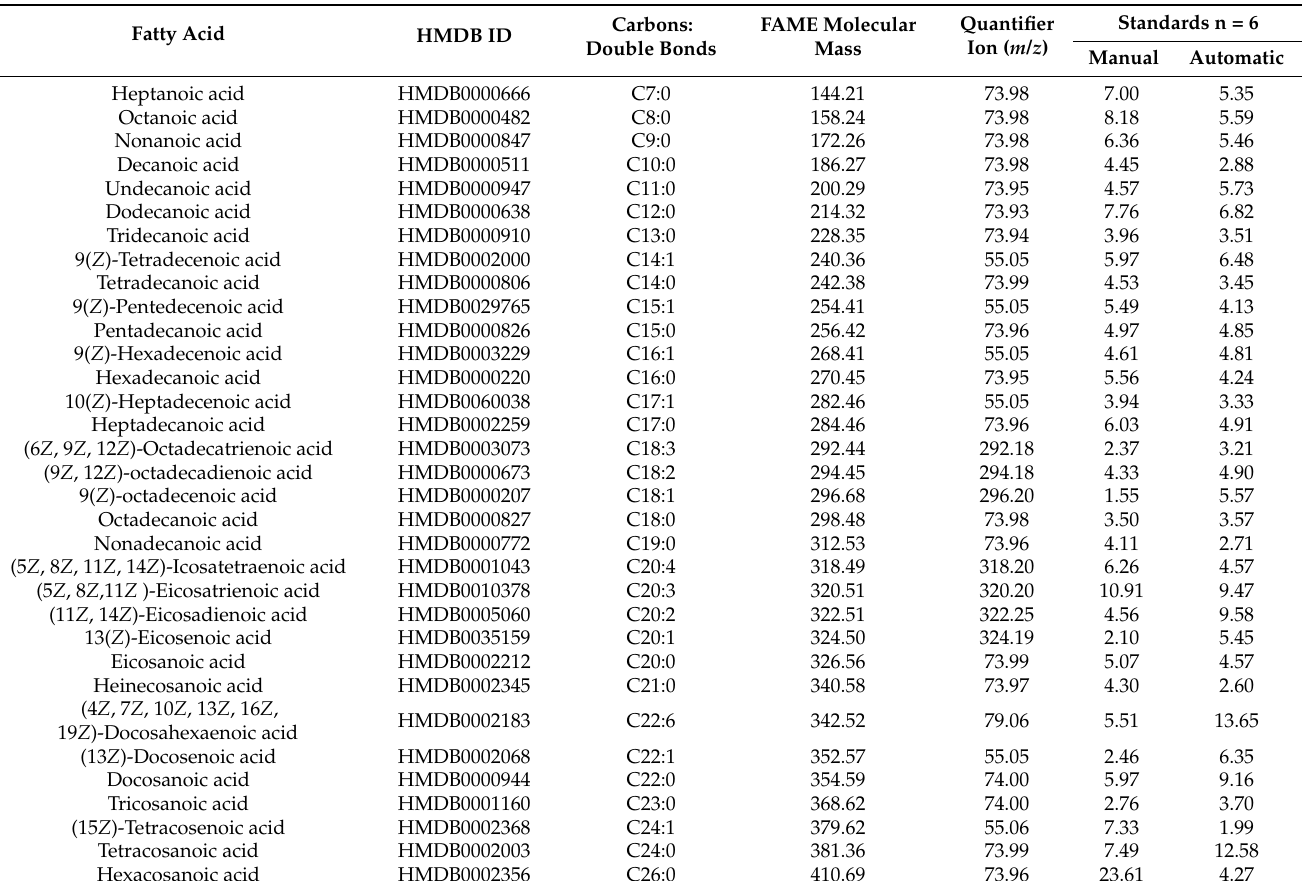
Table 1. Compiled relative standard deviations of analyzed free fatty acid standards after manual and automated TMSH derivatization. Improvements in reproducibility are indicated with bolded RSD